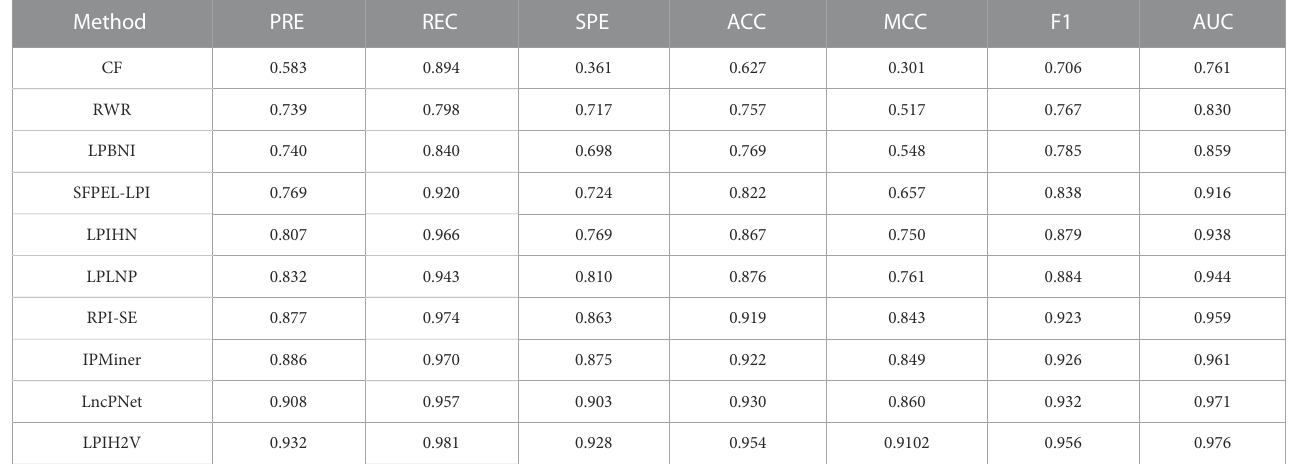
TABLE 2 Performance comparison of LPIH2V with other tools for predicting lncRNA-protein interactions.